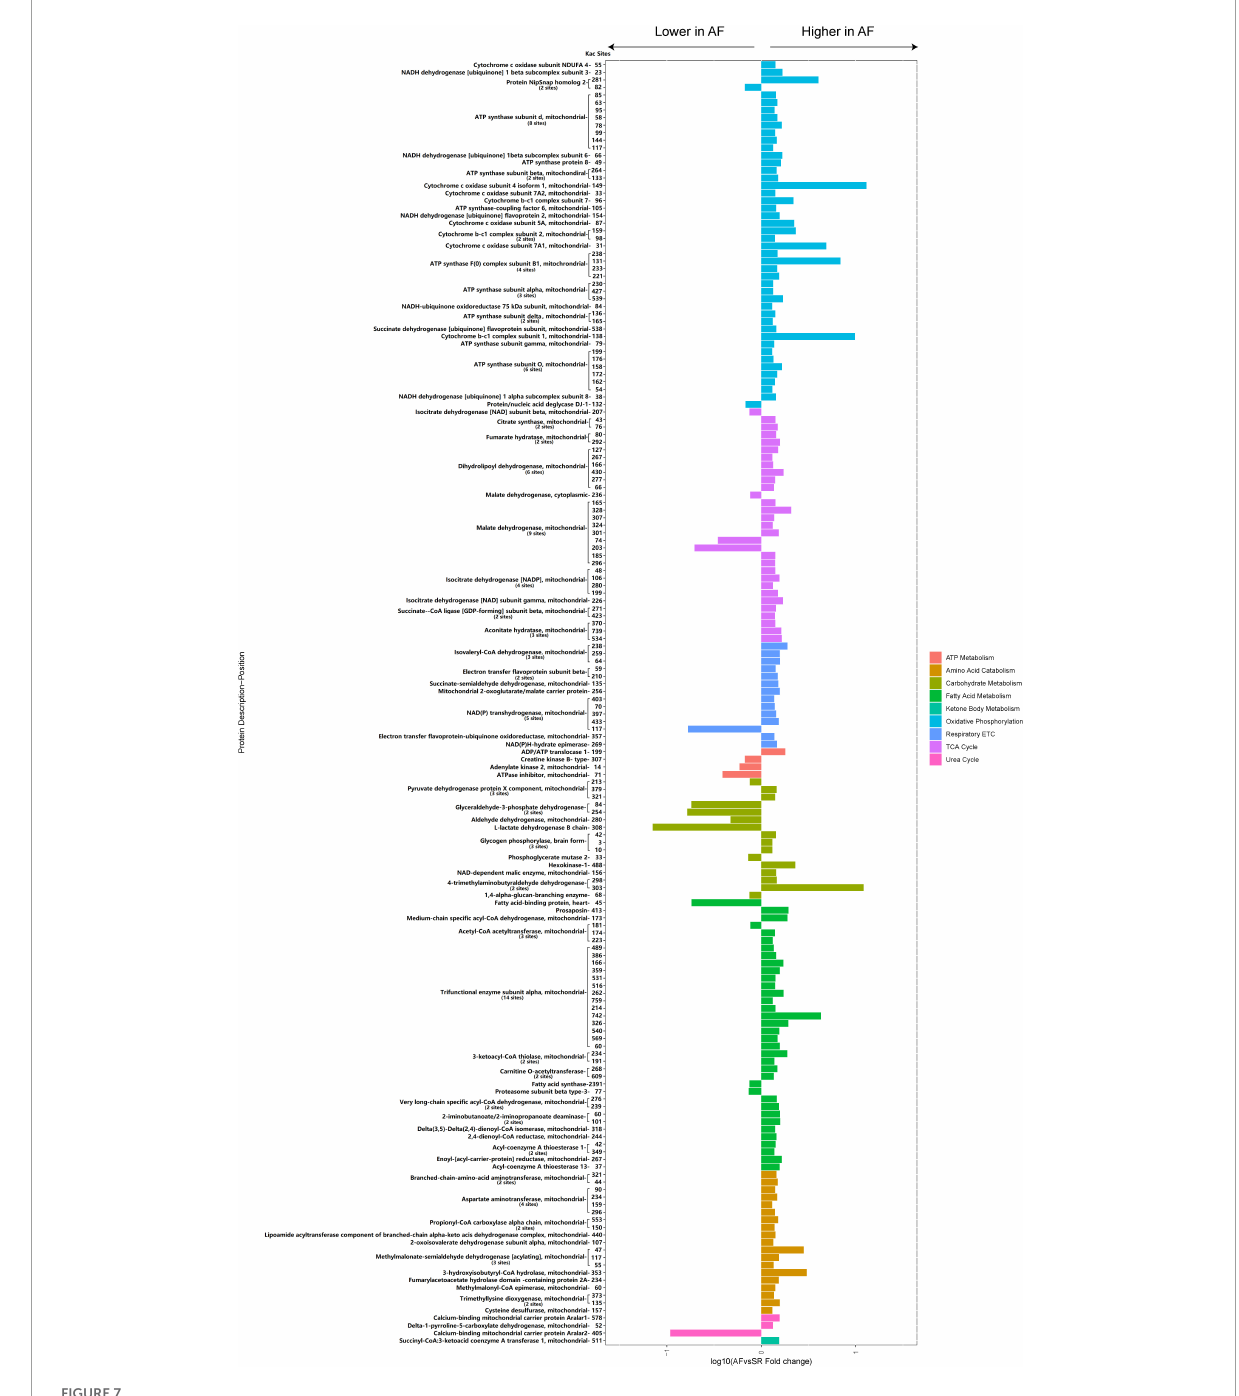
A total of 45 cellular contraction and structure-related Kac proteins (accounting for 23.3% of the total AF/SR differentially expressed Kac proteins) had 95 AF/SR differentially expressed acetylated sites (accounting for 27% of the total AF/SR